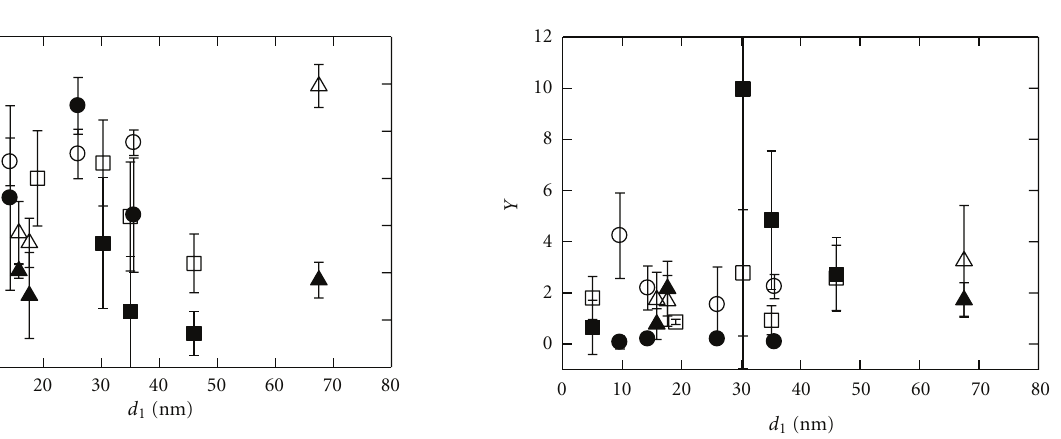
Figure 8: Normalized specific chlorophyll ( Y ) for three-NP samples. Circles are SiO 2 , triangles are Al 2 O 3 , and squares are TiO 2 . Solid symbols are 100 mg/L of exposure dosage. Closed symbols are 1000 mg/L of exposure dosage. Experimental conditions: initial algae concentration = 1 . 4 ± 0 . 9 × 10 6 cell/mL, test duration = 4 days, and initial test volume = 200mL.